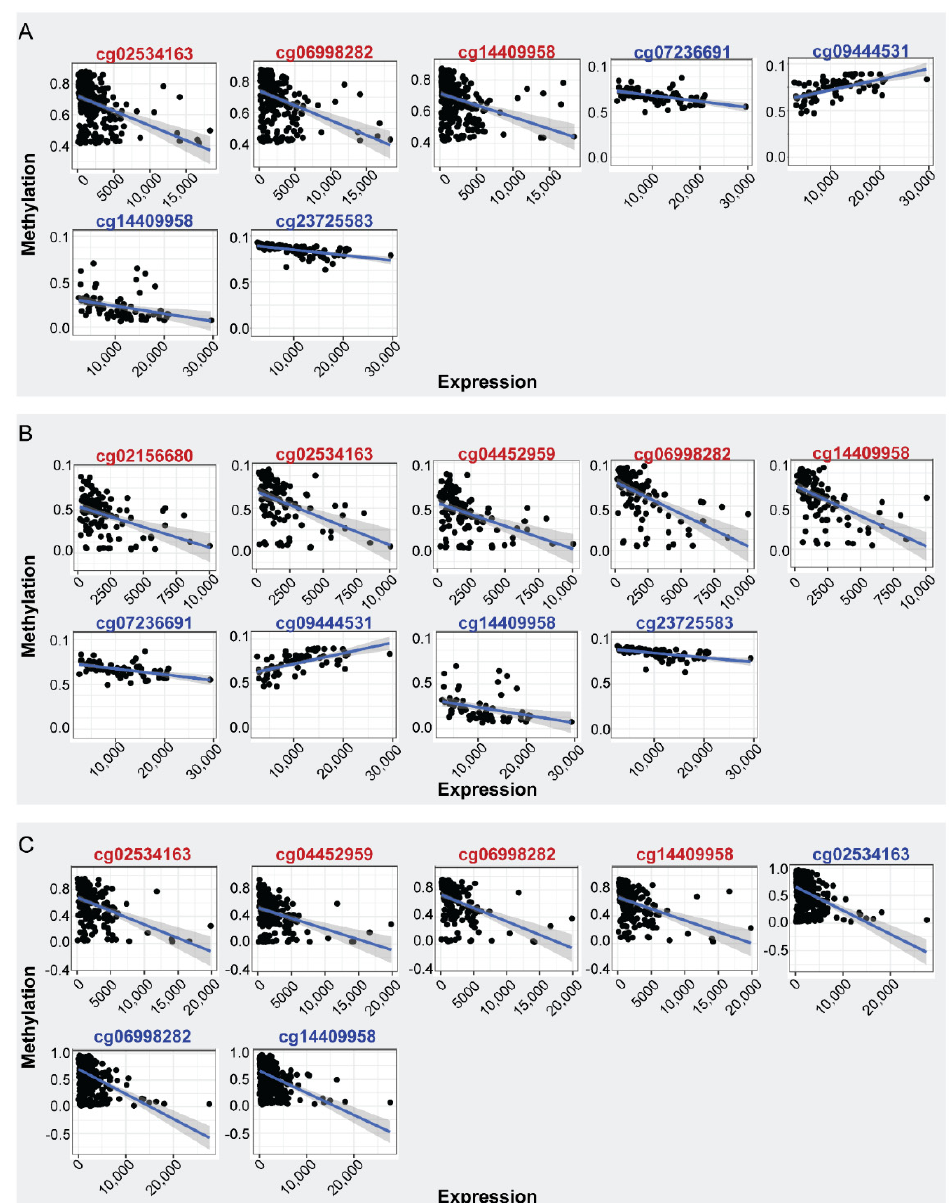
Figure 2. Spearman correlation of ENPP2 CGs methylation and mRNA expression. CGs showing significant correlations are depicted (|rho| >= 0.40, FDR < 5 × 10 − 2 ). ( A ) Expression-methylation scatter plots of CG sites of BrCa (red) and normal (blue) samples, ( B ) expression-methylation scatter plots of CG sites of BrCa stage I (red) and normal (blue) samples, ( C ) expression-methylation scatter plots of CG sites of advanced (red) and early (blue) BrCa samples .